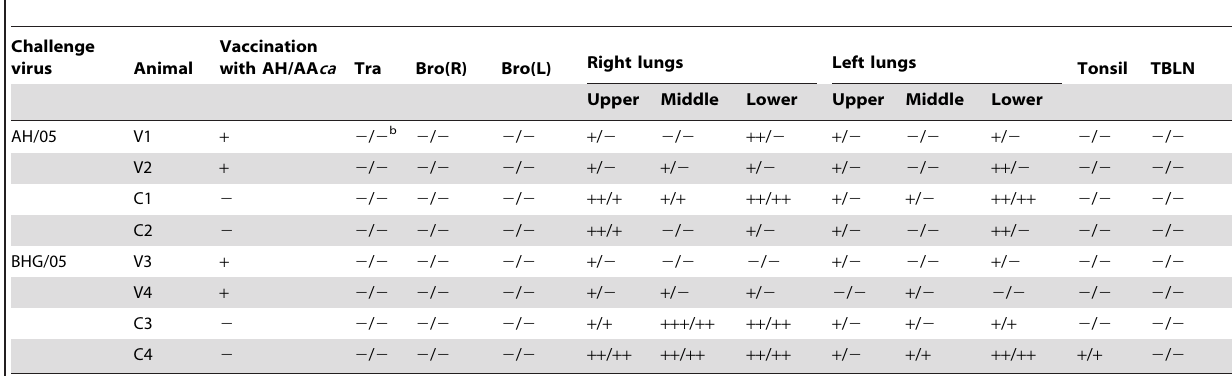
Table 5. Pathological lesions and antigen distribution in tissues of nonhuman primates infected with H5N1 viruses.